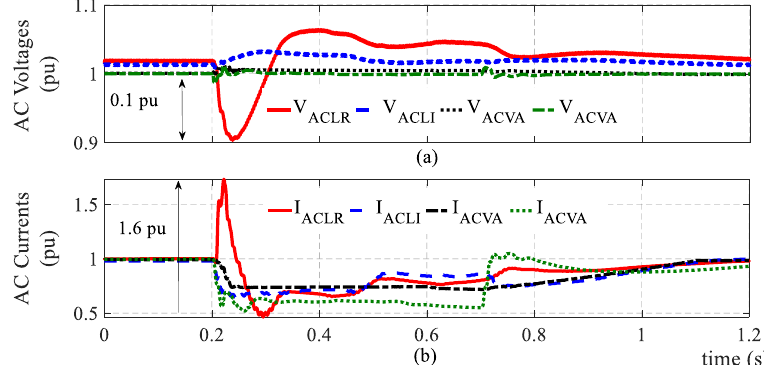
Figure 14. AC side measurements for a P-Pole-to-ground fault on the main transmission line ( a ) voltages, ( b ) currents.